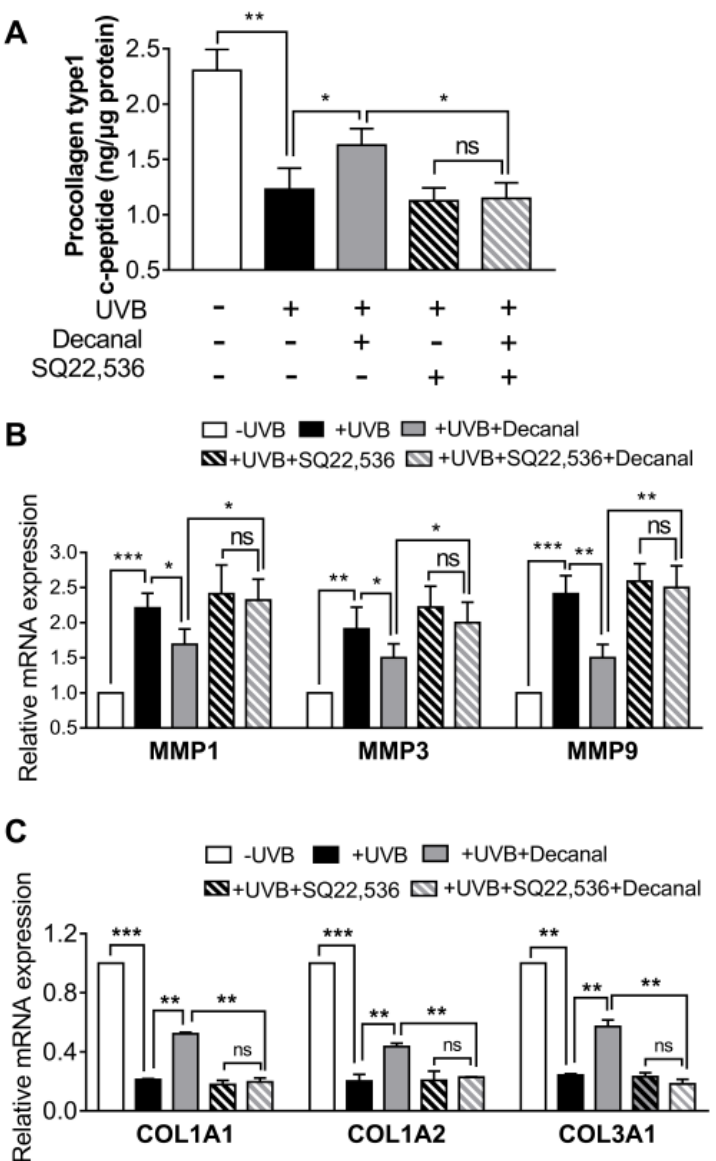
Figure 5. The e ff ect of decanal on collagen synthesis via the cAMP pathway. Hs68 cells were treated with decanal or the vehicle and exposed to UVB. The SQ22536 or the vehicle was pretreated for 1 h before the decanal treatment. ( A ) Collagen contents; ( B ) mRNA expression of matrix metalloproteinase ( MMP) 1, MMP3 and MMP9 ; and ( C ) mRNA expression of collagen type I alpha 1 chain ( COL1A1 ), COL1A2 and COL3A1 were analyzed. The final procollagen type I level was normalized to the total cellular protein content. Data are shown as the mean ± SEM ( n = 3). Significant di ff erences are indicated as * p < 0.05; ** p < 0.01; *** p < 0.001.